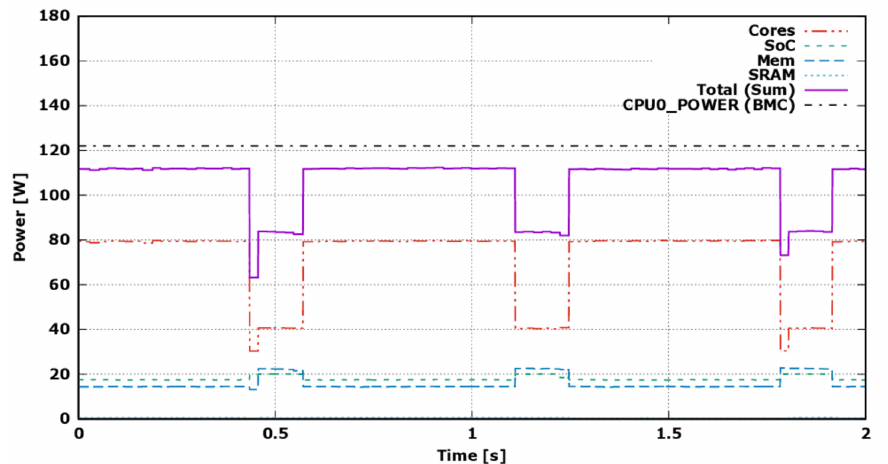
Figure 4. Data sampled using tx2mon , while running the LBM application on the ThunderX2 processor. The traces record subsequent iterations, with shorter periods corresponding to execution of propagate , and longer to that of collide. They report the values from all available sensors on one CPU (Cores, SoC, Mem, and SRAM), the sum of these (solid line), and the CPU0_POWER value acquired by IPMI.